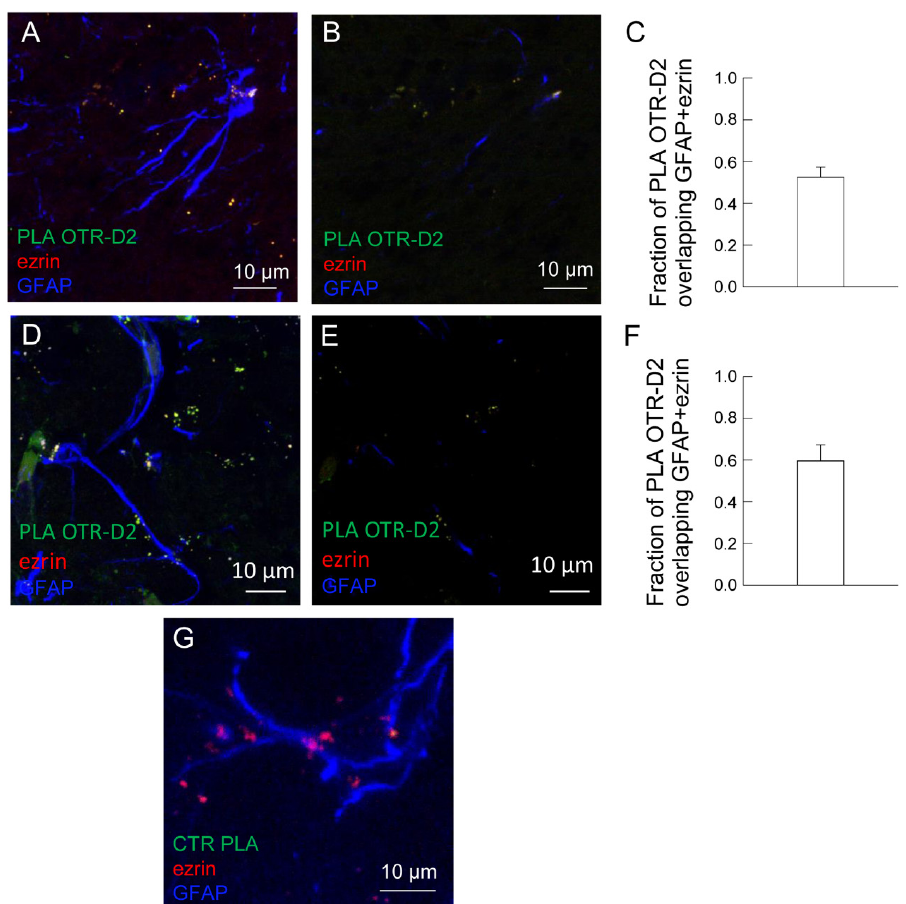
Figure 6. Striatal astrocytes express D2-OTR heterodimers. Representative confocal images showing the presence of the D2-OTR heterodimers in rat ventral ( A , B ) or dorsal ( D – E ) striatum. In situ Proximity Ligation Assay (PLA) for the D2-OTR heteroreceptor complexes was carried out in rat hemibrain slices using anti-D2R and anti-OTR. The primary antibodies were conjugated with PLA oligonucleotides (PLUS or MINUS) before the PLA experiments, accordingly to the manufacturer’s instructions. For details see Materials and Methods. ( A , D ) The image is the merge of the maximum intensity projections of a representative field (66 × 66 and 72 × 72 µm; z 10–14 µm); PLA for D2-OTR heterodimers (green), ezrin (red), GFAP (blue). ( B , E ) A single z stack of the image is shown. The bars ( C , F ) indicate the fractions (± SEM of n = 5–8 fields from three different preparations) of PLA OTR-D2 expressed on GFAP, ezrin, or GFAP + ezrin positive astrocytes. ( G ) In the control, a complete lack of stain for PLA D2-OTR heteroreceptor complexes was obtained. The control condition was conducted using only a primary antibody conjugated with PLA oligonucleotides (PLUS or MINUS). The image is the merges of the maximum intensity projections of a representative field (30 × 30 µ m; z 14 µ m). Scale bars are shown in the images. GFAP, glial fibrillary acidic protein; OTR, oxytocin receptor; PLA, proximity ligation